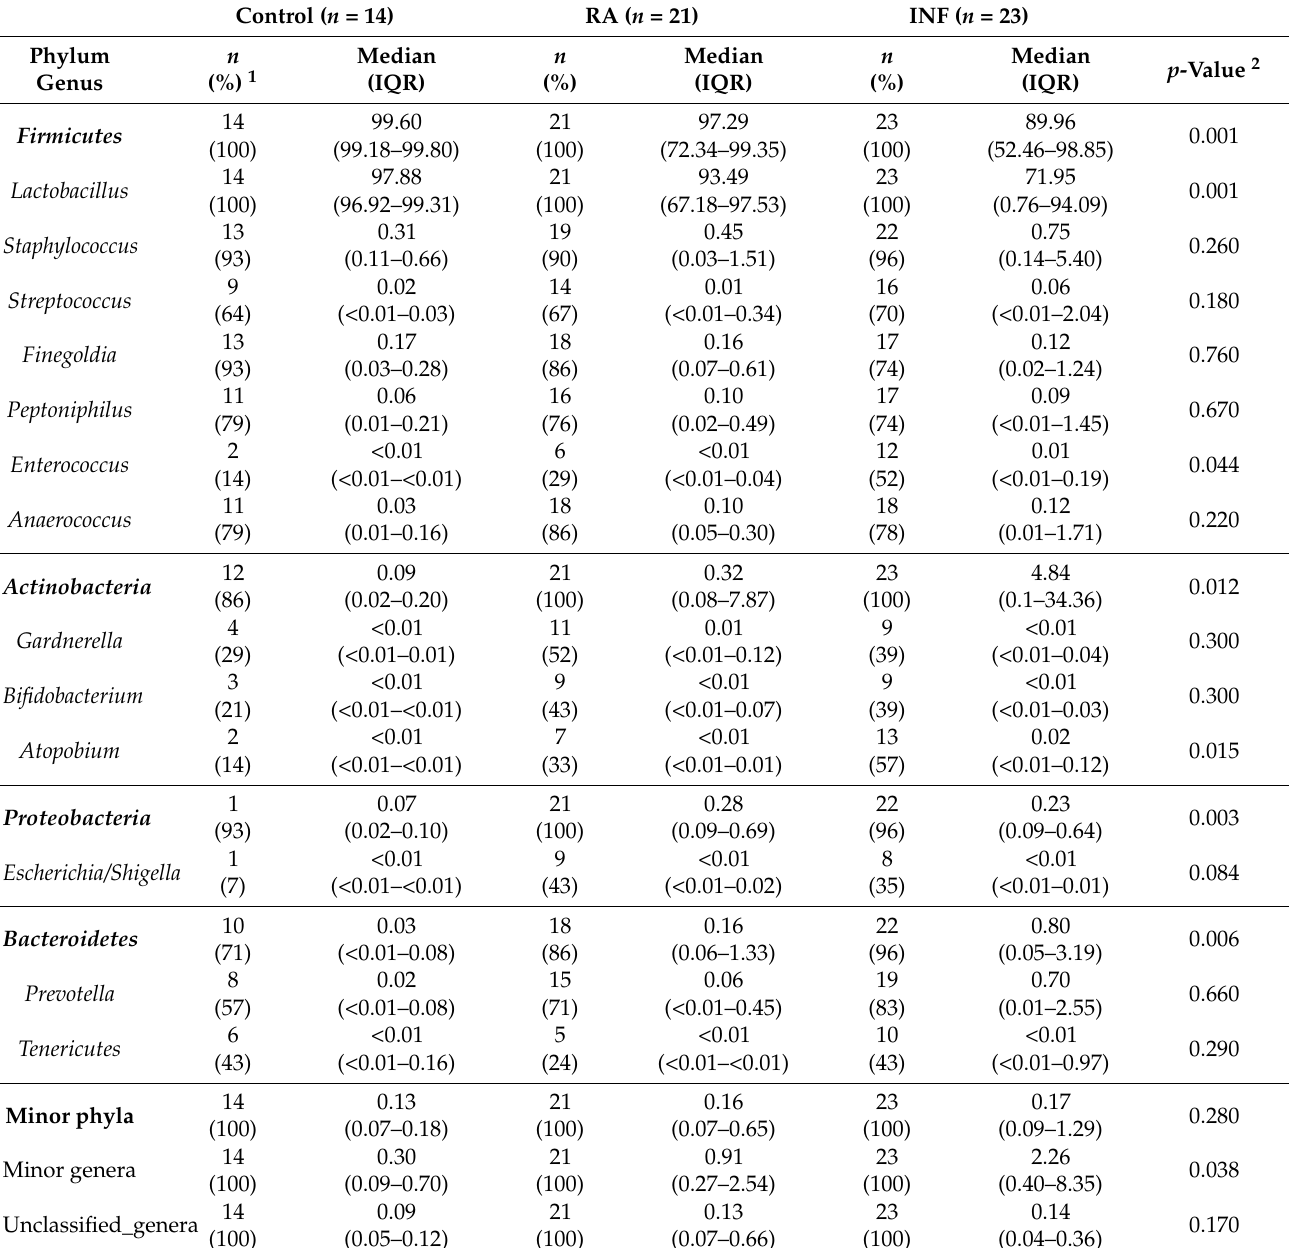
Table 3. Relative frequencies, medians and interquartile range (IQR) of the most abundant bacterial phyla and genera detected in CVL samples from fertile women (Control group), women with a history of repetitive abortion (RA group), and women with infertility of unknown origin (INF